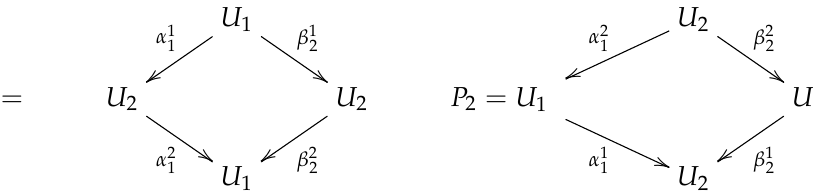
Figure 5. Indecomposable projective Λ Γ 2 -modules. Note that the number of composition series equals the number of non-truncated vertices in the corresponding polygon.